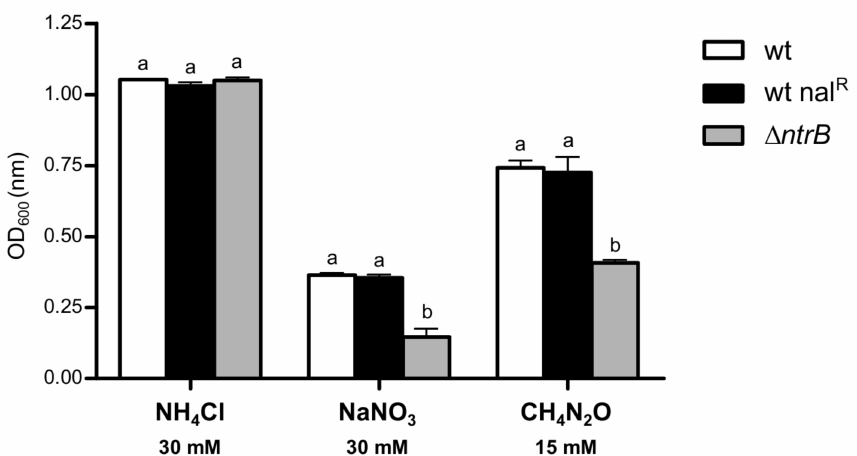
Figure 5. Utilization of selected nitrogen sources by P. phymatum wild-type (wt), nalidixic acid-resistant wild type (wt nal R ), and by a ntrB deletion mutant strain ( ∆ ntrB ). Growth was assessed with at least two independent replicates. Error bars indicate standard deviation (SD). For each group of columns, values with the same letter are not statistically different, while those with different letters are (ANOVA, Tukey’s test, p <